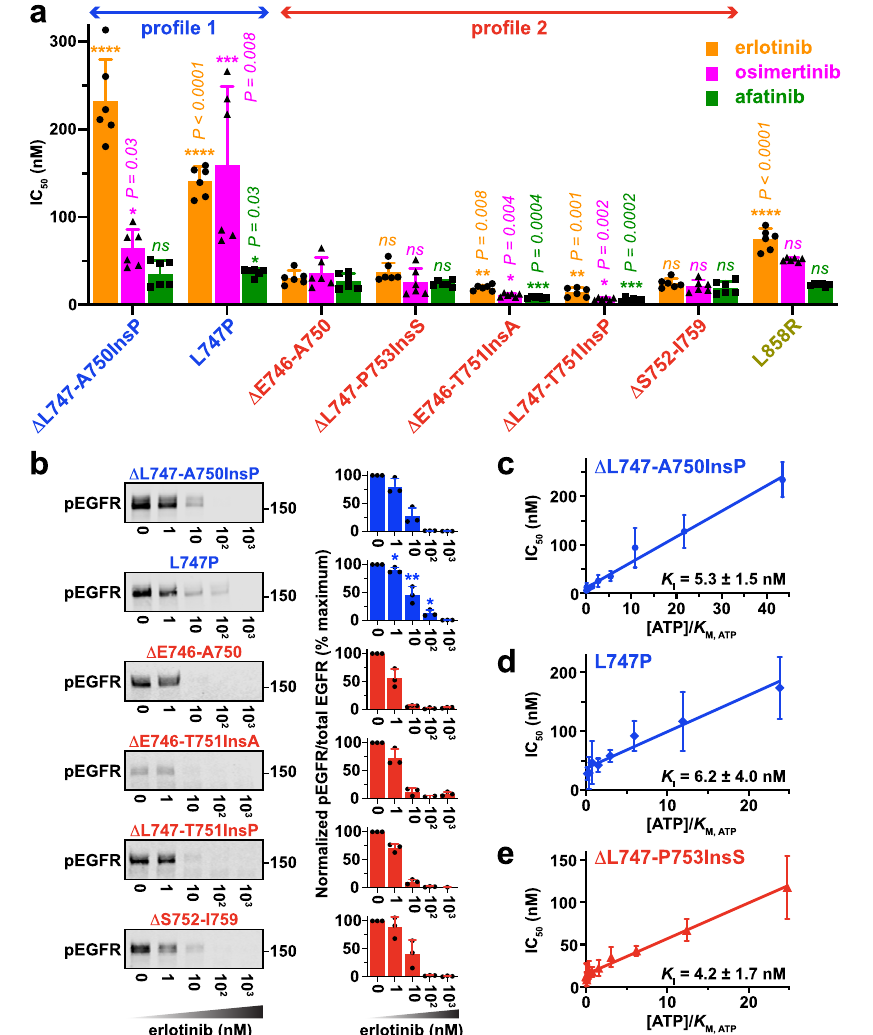
Fig. 2 | Quantitation of in vitro inhibitor sensitivity of other EGFR exon 19 variants. a Bar graph of IC 50 values for erlotinib (orange), afatinib (green), and osimertinib (magenta) obtained from dose-response curves using puri fi ed TKD as described in Methods. All IC 50 values represent means (± SD) for n =3 separate proteinpreparations,withtwoindependentexperimentsforeach.Asterisksdenote whether IC 50 is signi fi cantly different for a given TKI (erlotinib, osimertinib or afatinib) when compared (pairwise) with the value obtained for Δ E746-A750. P values from unpaired two-sided Student ’ s t-tests are given when <0.05 (* P <0.05; ** P <0.01; *** P <0.001, **** P <0.0001). Based on these IC 50 values, we classify the exon 19 variants into two pro fi les: Pro fi le 1 (Blue: resembling Δ L747-A750InsP) or Pro fi le 2 (Red: resembling Δ E746-A750) — see also Supplementary Fig. 2. b pEGFR immunoblots of total cell lysates from CHO cells transfected with full-length EGFR constructs harboring the indicated exon 19 mutations. Cells were treated with